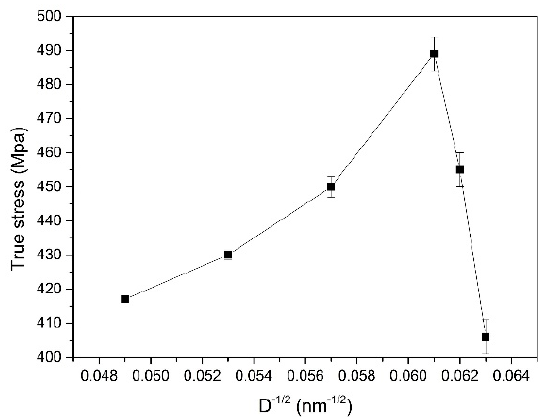
Figure 11. The Hall-Petch relationship in micro-rolling with different grain sizes.